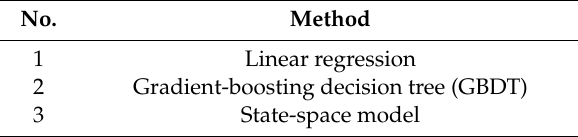
Table 4. Methods selected as candidates for rack intake temperature prediction